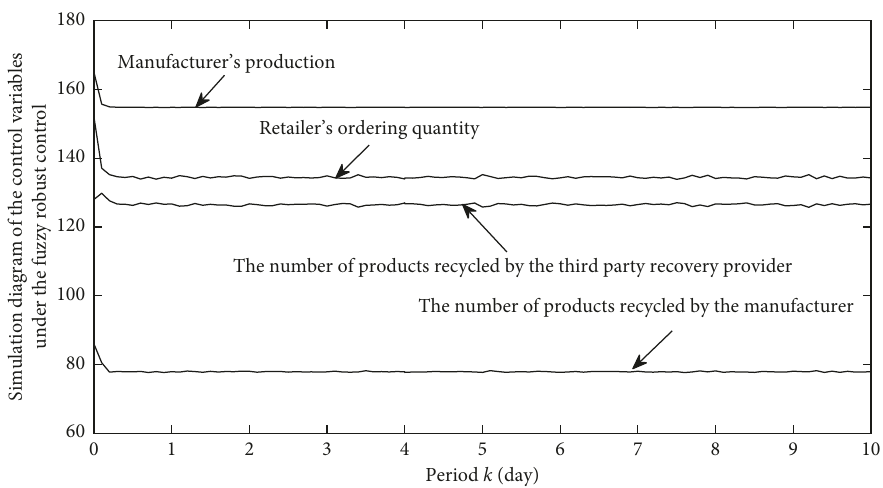
Figure 7: Simulation diagram of the control variables under FRC (unit: × 10 3